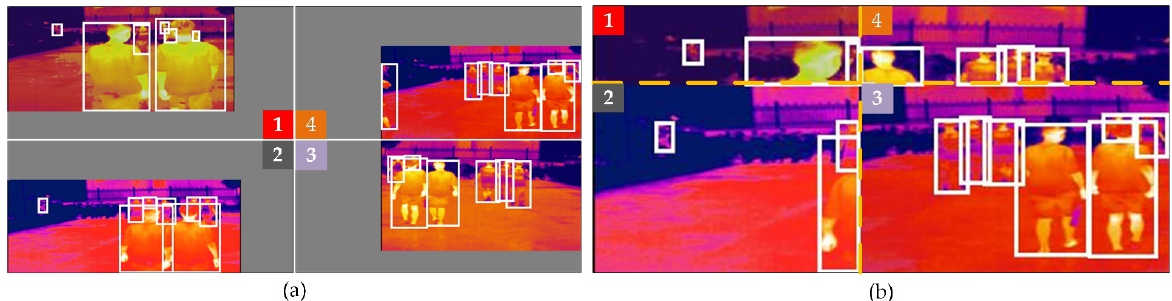
Figure 2. Mosaic data augmentation. ( a ) contains four images, corresponding to 1–4, each of which is processed through the data augmentation strategy described in Section 3.1; ( b ) is an image composed of 1–4 in ( a ), where the white boxes in the figure represent the ground-truth label.